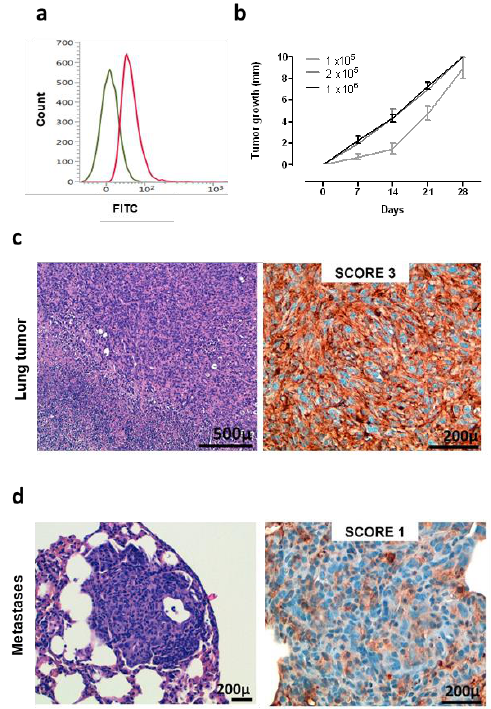
Figure 3. Characterization of KL-ROS1 cell line. ( a ) Representative cytofluorimetric analysis of anti-ROS1 (D4D6) (red line) or control unrelated IgG isotype Ab (green line) staining on KL-ROS1 cells. ( b ) Graph showing the tumor growth of KL-ROS1 cells injected subcutaneously in wt mice at different doses. Data are expressed as mean tumor diameters ± SD for each experimental group (N = 3–5 mice). ( c,d ) Representative H&E (left panels) and IHC staining for the ROS1 protein (right panels) of ( c ) an explanted 10 mm mean diameter KL-ROS1-derived tumor and ( d ) a spontaneous KL-ROS1-derived lung metastases. N = 4 mice were analyzed.